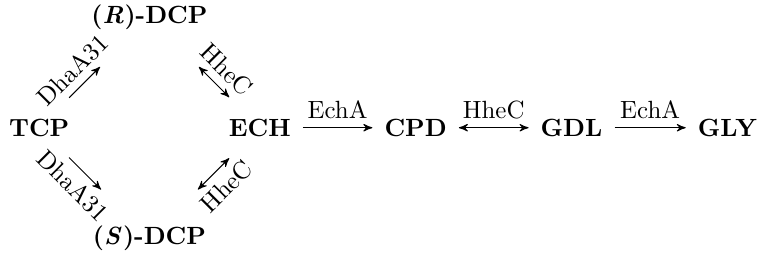
Figure 1. Model of metabolic pathway for biodegradation of TCP. A general scheme of an enzymatic metabolic pathway for biodegradation of TCP into GLY. Note that DhaA31 produces two different enantiomers of 2,3-dichloropropane-1-ol (DCP) with similar rate. However, enzyme HheC has notably different enantioselectivity with them. It is also worth noting that enzymes HheC and EchA are employed twice in the pathway. Other intermediates are epichlorohydrin